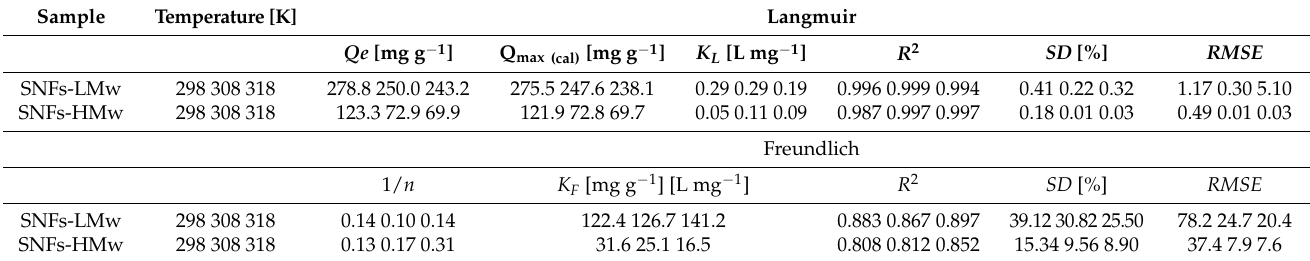
Table 3. Langmuir and Freundlich parameters of SNFs-LMw and SNFs-HMw for MB derivate from isotherms adsorption.